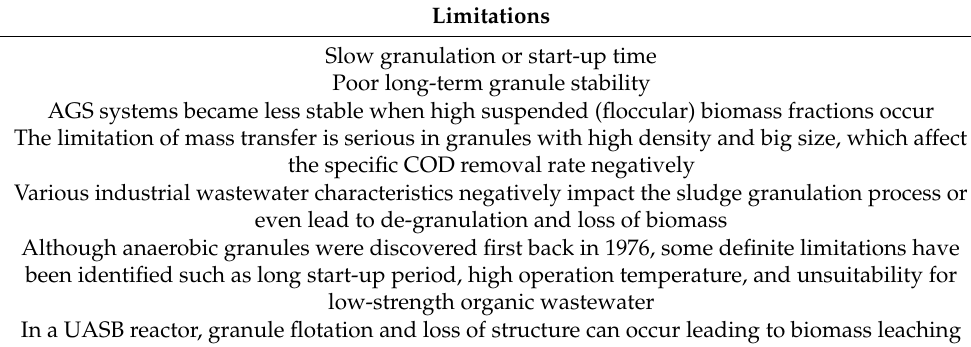
Table 5. Problems of granular-sludge